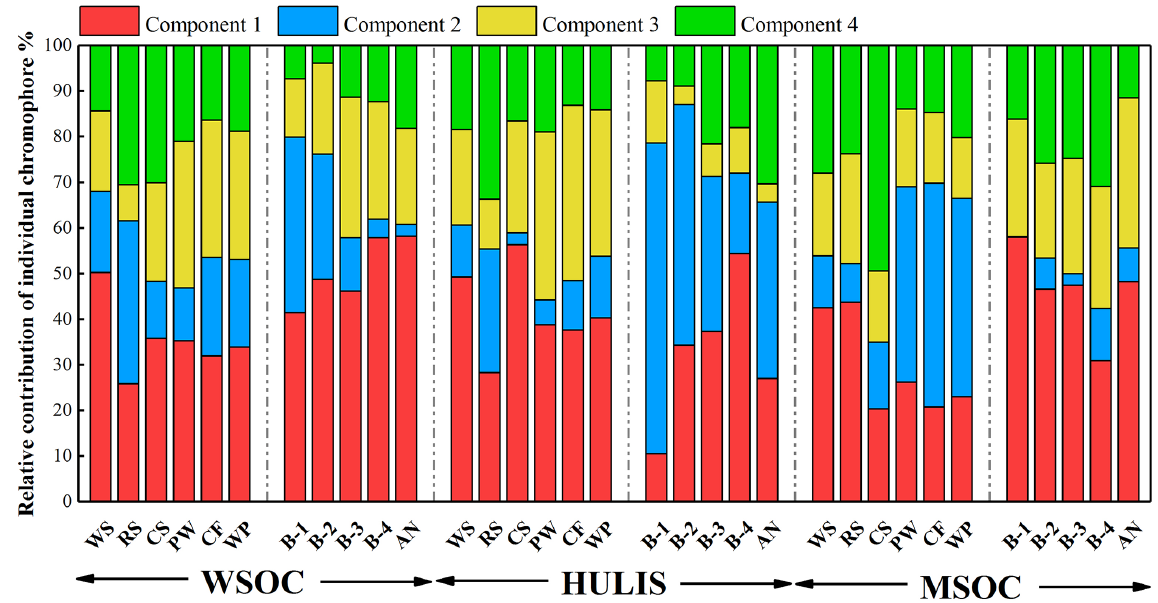
Figure 4. Relative contribution calculated by F max of individual chromophores analyzed by PARAFAC. Components 1–4 represent C W 1–4 for water-soluble BrC (WSOC and HULIS) and C M 1–4 for methanol-soluble BrC (MSOC), respectively. Table 2. The proton species in the BrC fractions (WSOC, HULIS, and MSOC) of smoke samples. WSOC HULIS MSOC